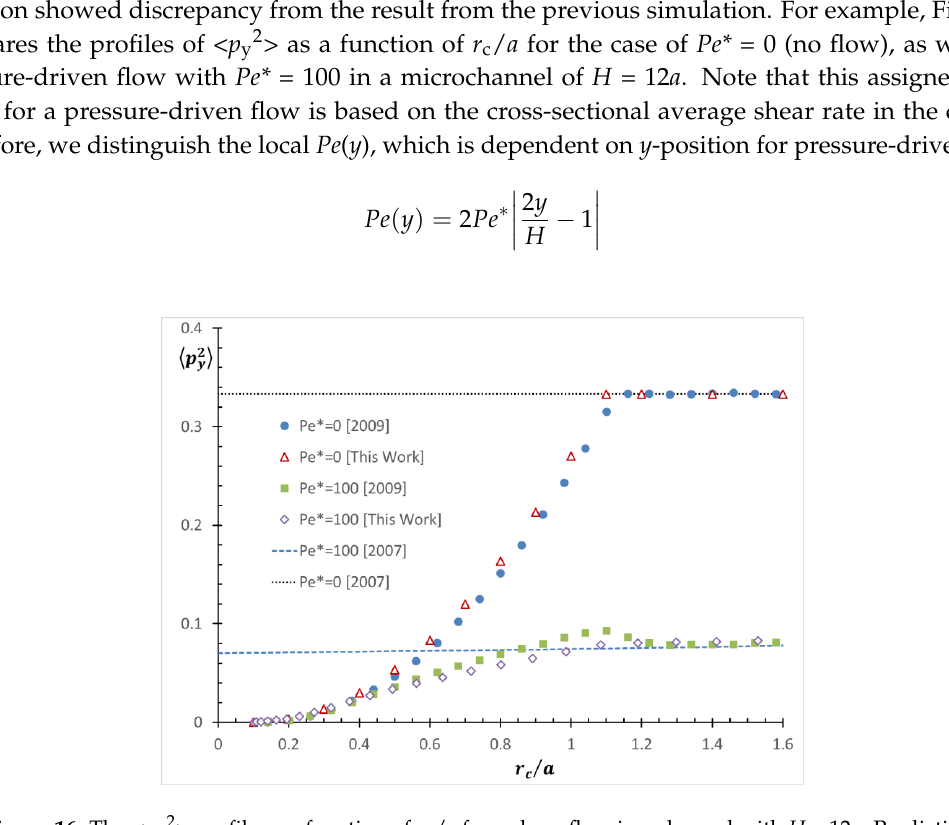
Figure 15. Average orientation moment < p x p y3 > as a function of Pe with various α / a .